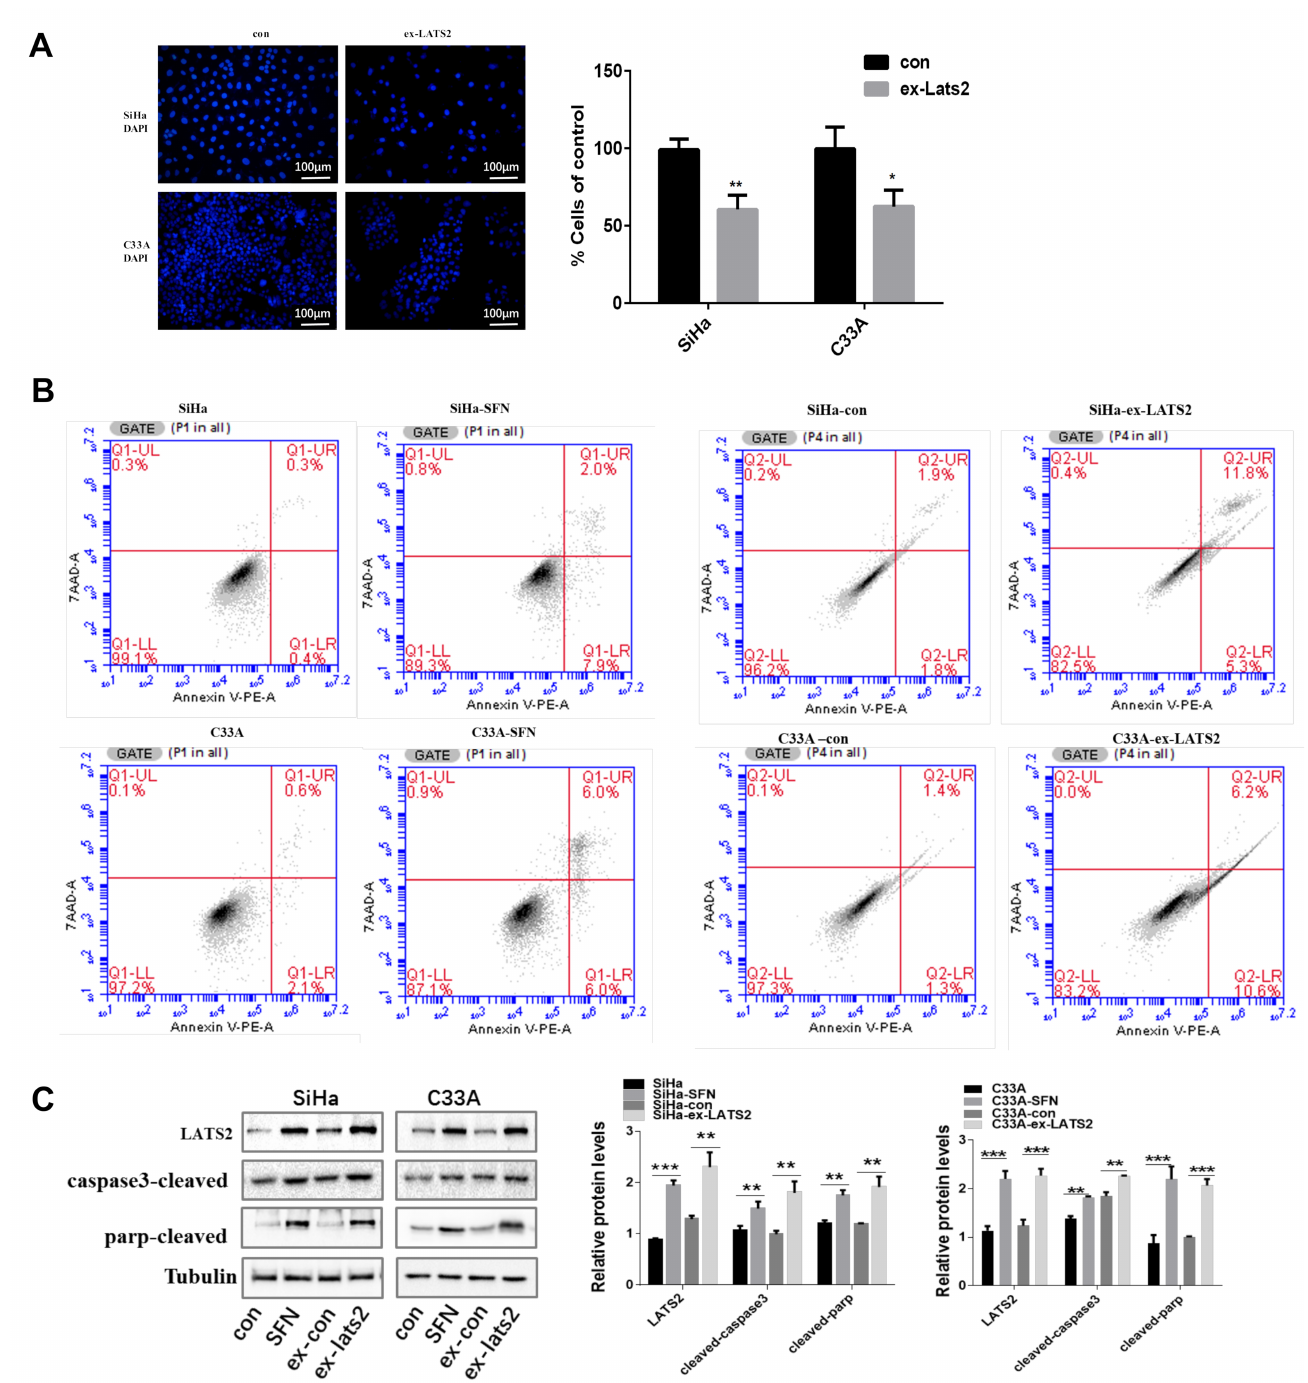
Figure 2. LATS2 suppresses cervical cancer cell proliferation and promotes apoptosis. ( A ) Prolifera- tion of SiHa and C33A with LATS2-overexpressing cells and their respective controls was assessed by DAPI staining and nuclear counting using CellProfiler. ( B ) Cell apoptosis was evaluated by flow cytometric analysis. SiHa and C33A were treated with SFN (20 and 15 µ M, respectively) for 48 h, or transfected with LATS2 overexpression plasmid (ex-LATS2) or control vector. The data shown are from a single representative experiment performed in triplicate. ( C ) Western blot analysis of the levels of cleaved caspase-3 and cleaved PARP. Cropped blots were showed in Western blotting. The samples derived from the same experiment and those blots were processed in parallel. * p < 0.05, ** p < 0.01, *** p <